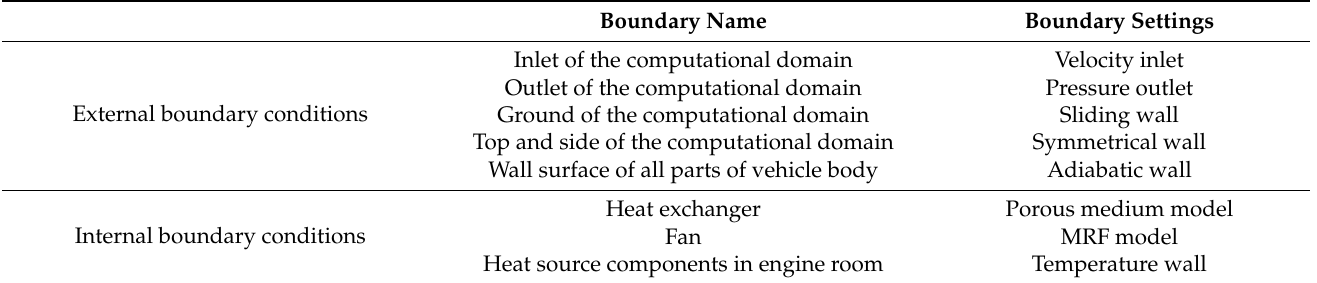
Table 1. Setting of boundary